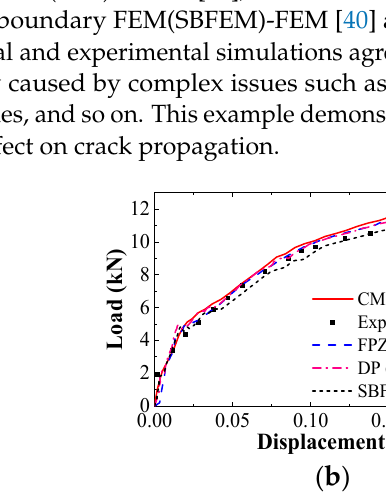
Figure 3. Load history used for the impact test.